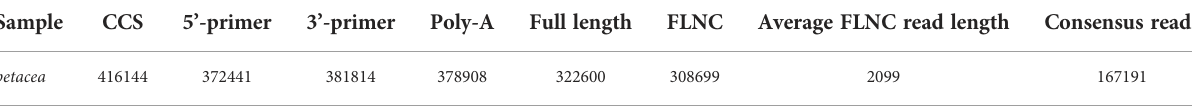
TABLE 1 Summary of circular consensus sequence of tree tomato ( Solanum betaceum Cav.) generated by SMRT sequencing technology.